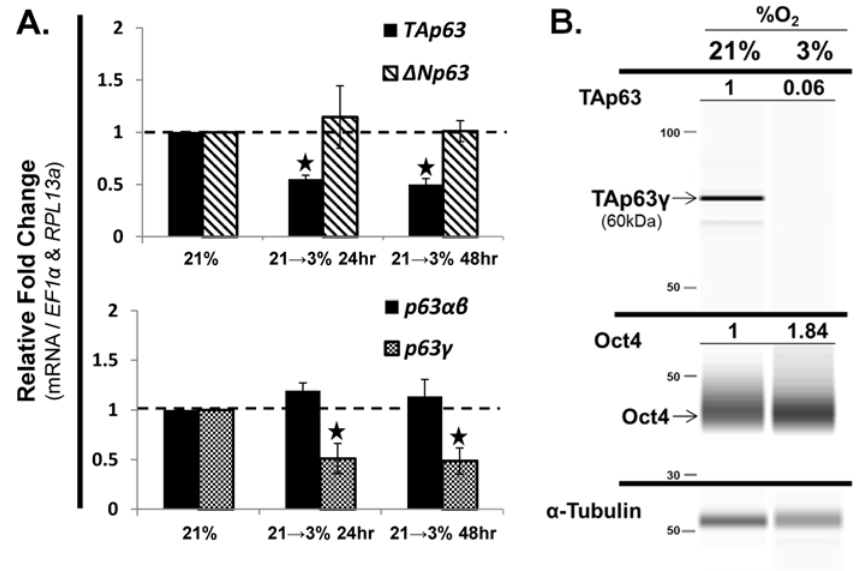
Fig 8. Low oxygen decreased TAp63 and p63 γ mRNA expression. hMSC were seeded at 1,000 cells/cm 2 and grown under expansion conditions in a normoxic atmosphere (21% O 2 ), and then switched to low oxygen (3% O 2 ) for 24 or 48 hours (A) or grown in 3% O 2 for 1 week and then passaged once (B). A) RT-qPCR analysis of mRNA expression of p63 isoforms (top panel, TA- and Δ Np63 ) and splice variants (bottom panel, p63 α / β and p63 γ ). B) Assessment of protein levels of TAp63 using the Simon SimpleWestern System (ProteinSimple, see Methods). Oct4 is known to increase under low oxygen conditions and was used as a positive control. α -tubulin was used as an internal loading control to quantify the percent change in the protein expression levels of TAp63 and Oct4 (percent change, normalized to α -tubulin, denoted above each lane). Molecular weight of TAp63 corresponds with TAp63 γ (60kDa). Molecular weight of Oct4 corresponds to the Oct4 splice varaint Oct4a (~40kDa). N = 3 independent experiments in triplicate. ( * ) p (cid:1) 0.05 compared to hMSC expanded under normoxic conditions (21%). hMSC used were from a 7 and 22 year old